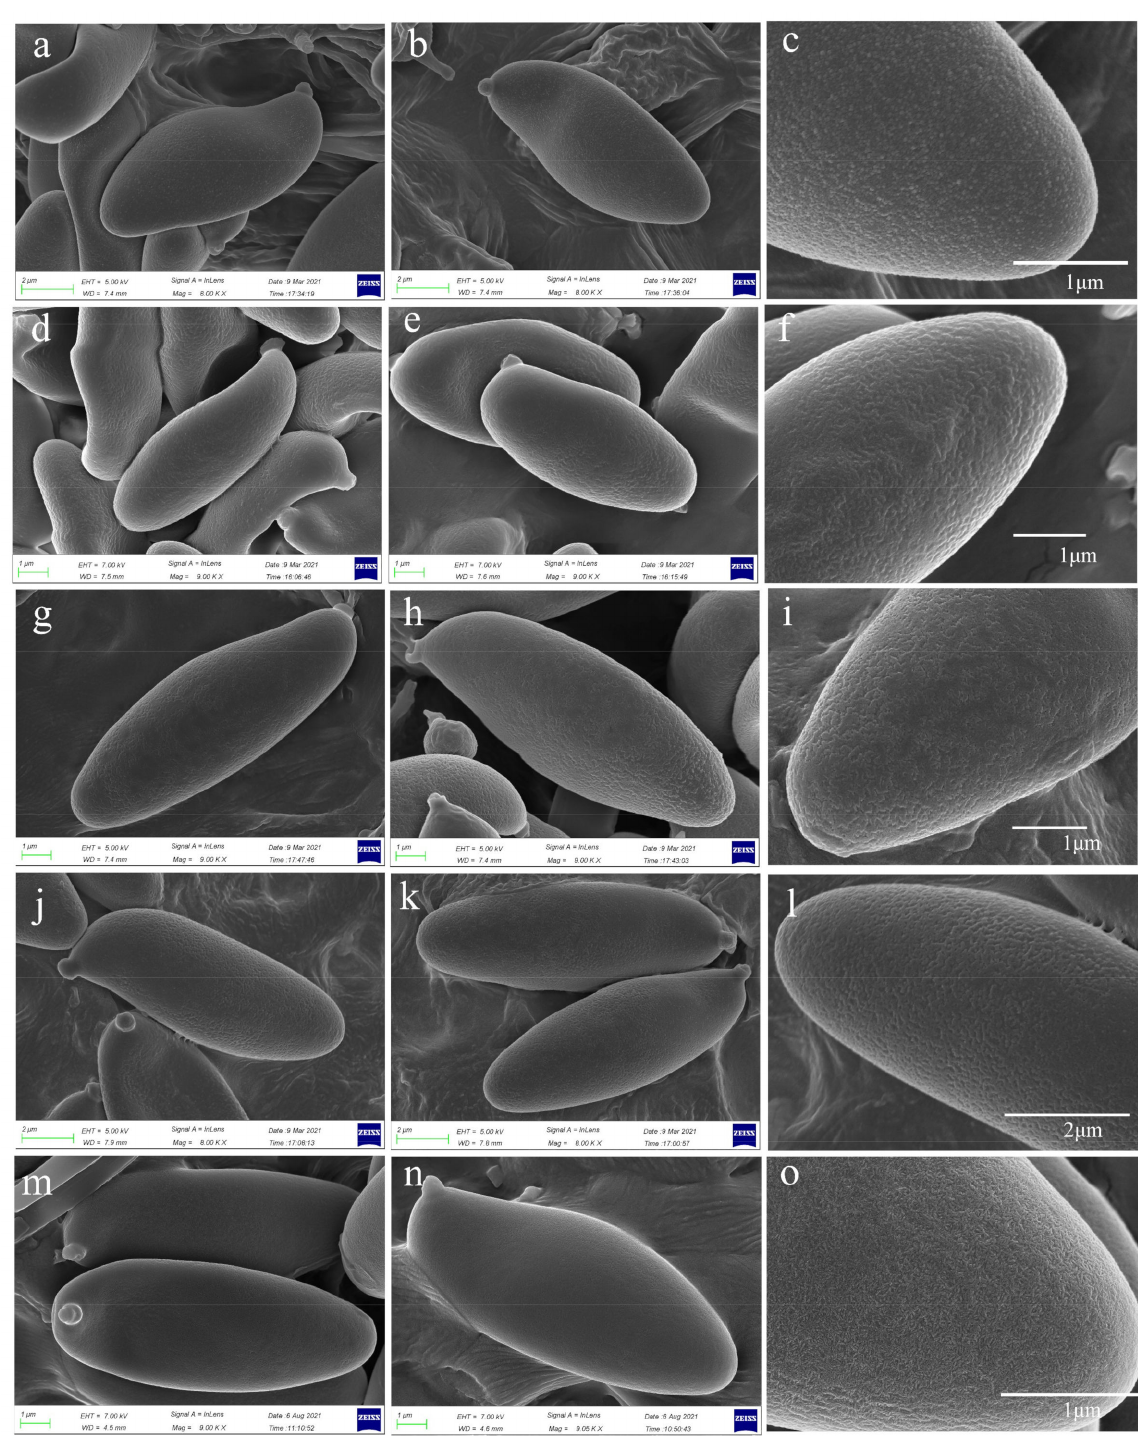
Figure 4. Basidiospores of Hemileccinum albidum , H. brevisporum , H. ferrugineipes , H. parvum and H. impolitum under SEM. ( a – c ) H. albidum (Type, KUN-HKAS81120); ( d – f ) H. brevisporum (Type, KUN-HKAS89150); ( g – i ) H. ferrugineipes (Type, KUN-HKAS115554,); ( j – l ) H. parvum (Type, KUN-HKAS115553); ( m – o ) H. impolitum